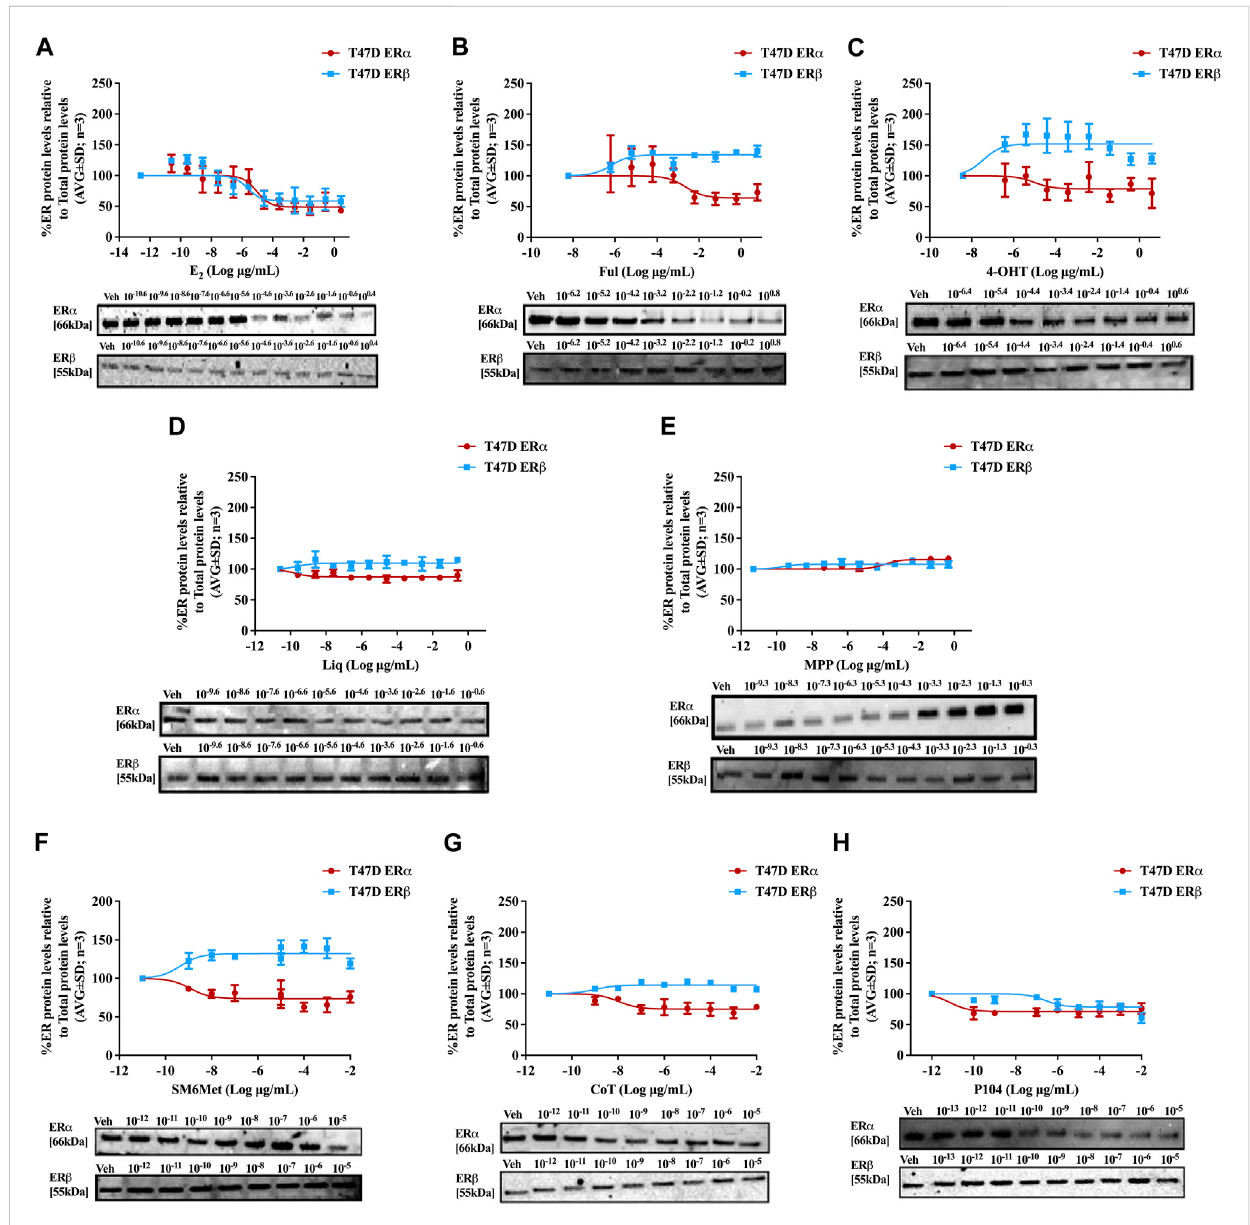
FIGURE 3 Effect of testpanel on ER α and ER β proteinlevels in T47D cells. T47D cells were steroid starved for 24 h and then treated with either vehicle (DMSO) or increasing concentrations of (A) E 2 , the SOCs, (B) fulvestrant (Ful) or (C) hydroxytamoxifen (4-OHT), or the ER subtype selective ligands, (D) liquiritigenin(Liq)or (E) methyl-piperidino-pyrazole(MPP),orthe Cyclopia extracts, (F) SM6Met, (G) cupoftea(CoT)or (H) P104foranother24 h.TheER α and ER β protein levels were determined using Western blot. The western blots shown as inserts are representative of three independent experiments.Forquanti fi cation,theintensityoftheER α andER β bandsweredeterminedwithMyImageAnalysissoftware,afterwhichtheobtainedvalues were normalized to total protein content and expressed as a percentage (AVG ± SD) of DMSO, which was set at